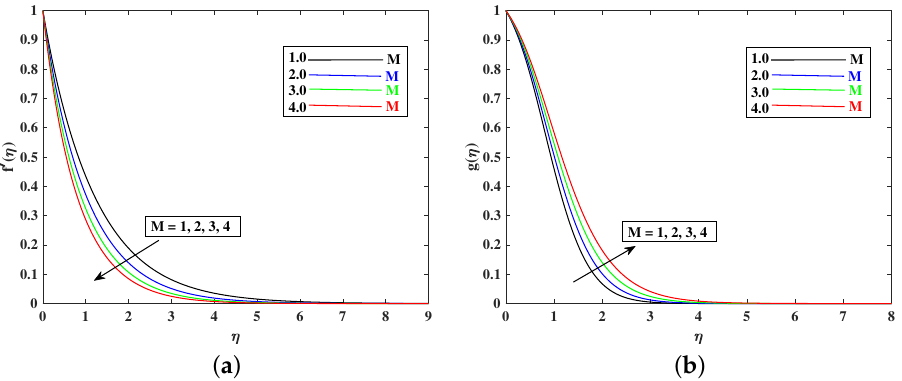
Figure 2. Variation of M to influence the velocity and temperature profile. ( a ) Variation of M to influence the velocity. ( b ) Variation of M to influence the temperature.